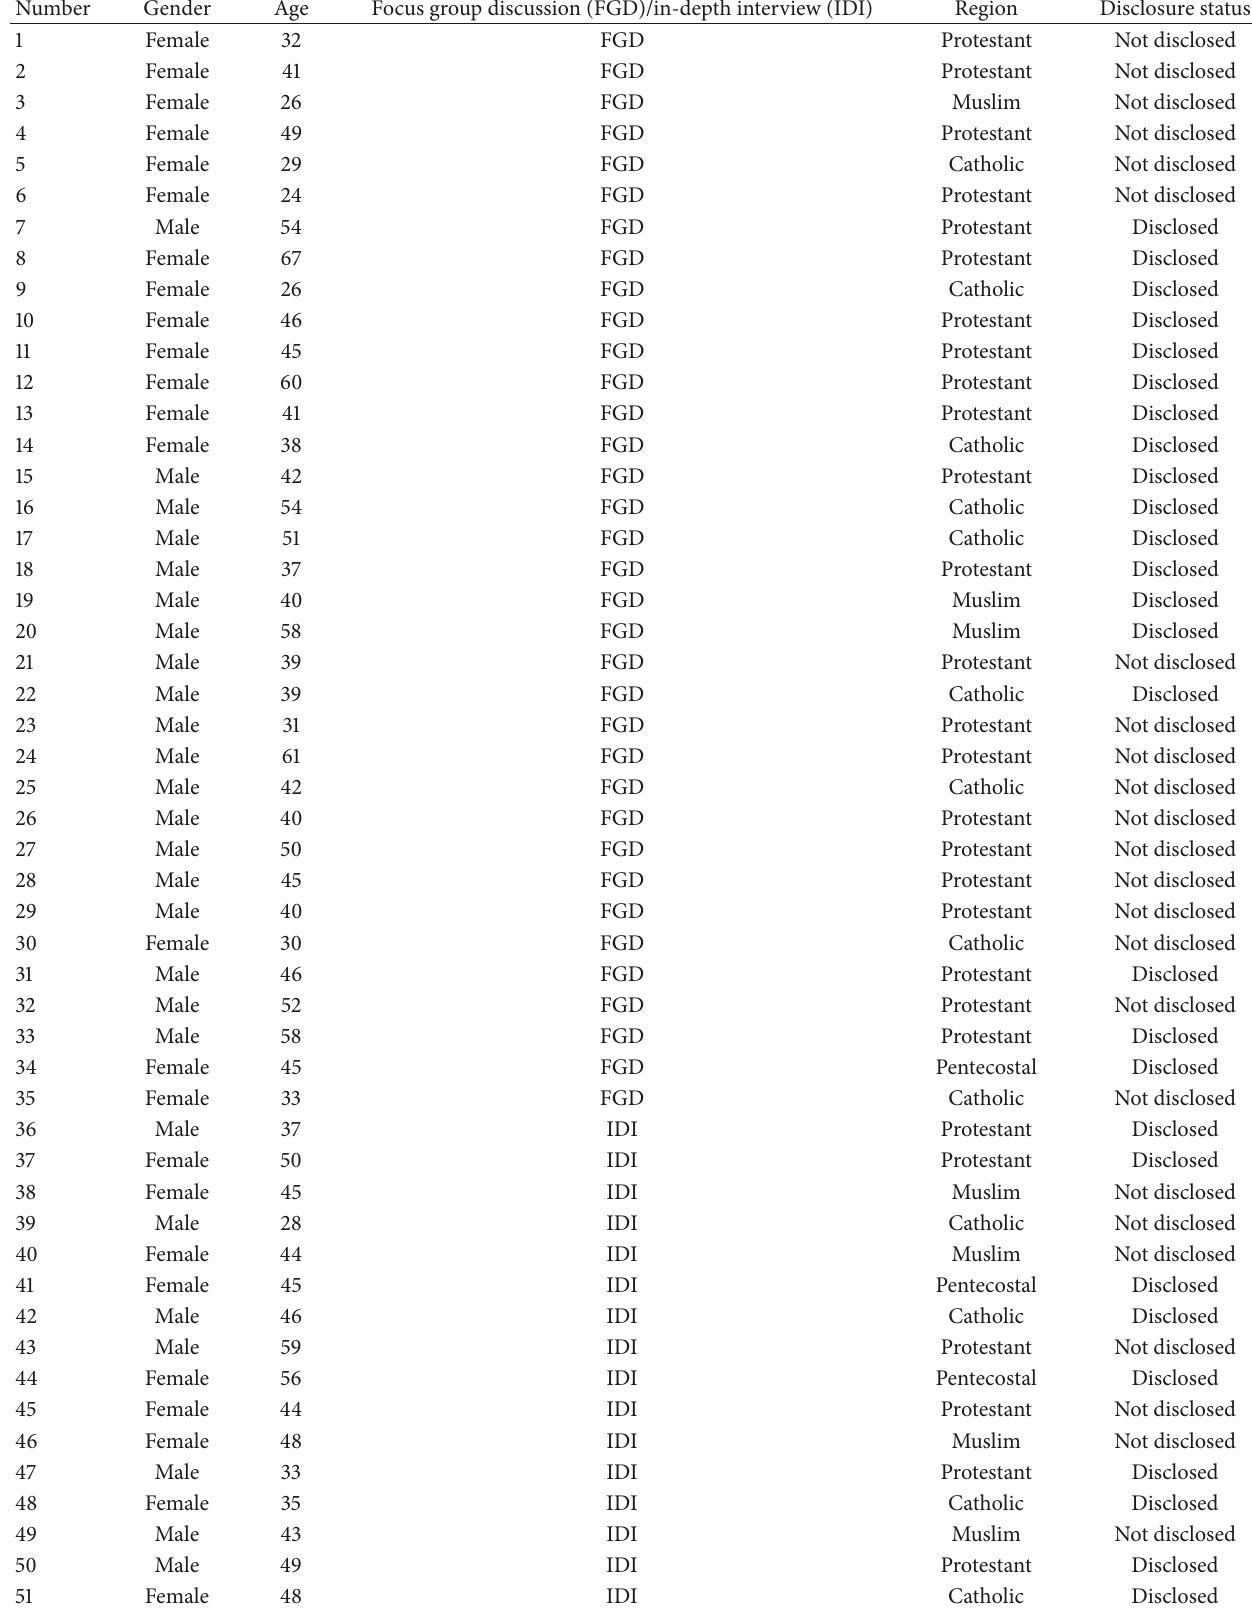
Table 1: Sociodemographic characteristics of study